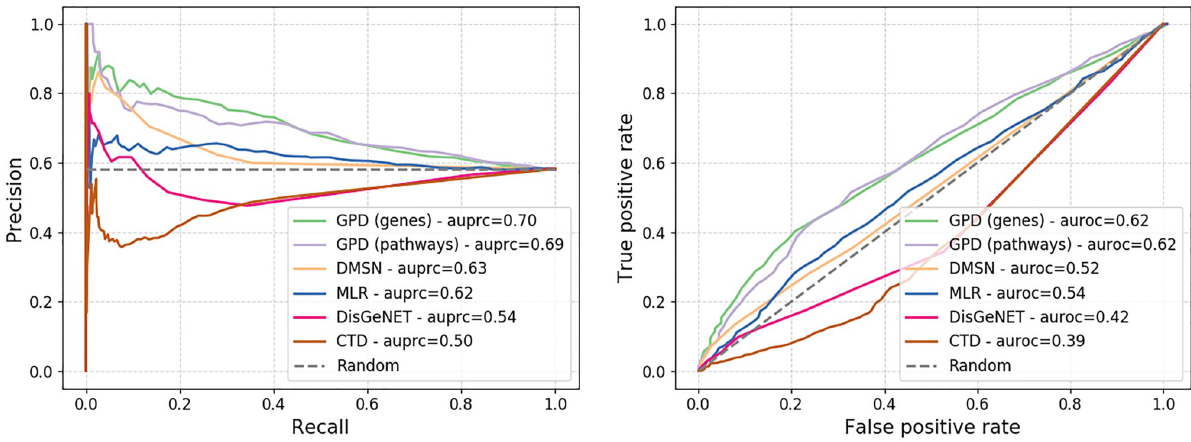
Fig 2. Precision–recall (top) and ROC (bottom) curves of the test against the disease co-morbidity network built by Hidalgo et al . [12].